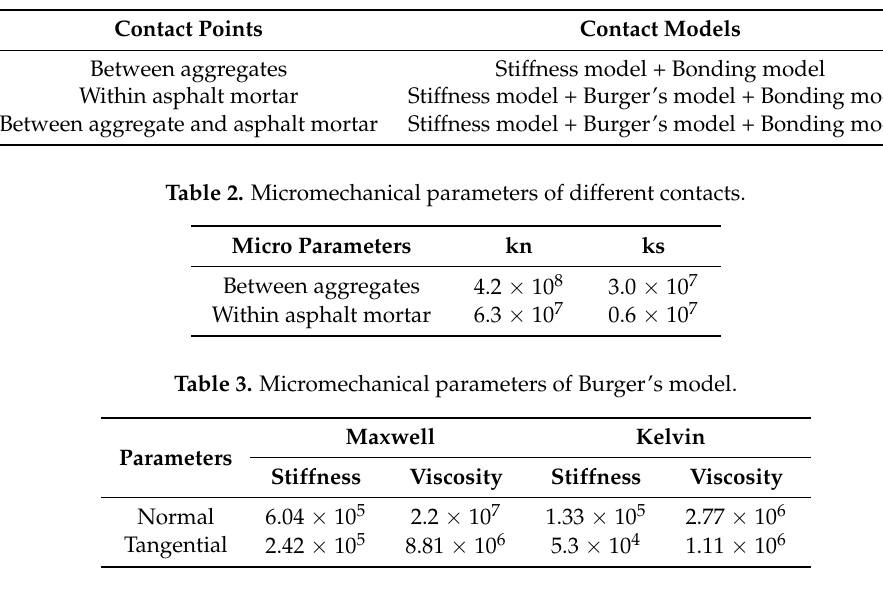
Figure 4. Schematic diagrams of different contact models. Table 1. Contact models of the asphalt mixture.